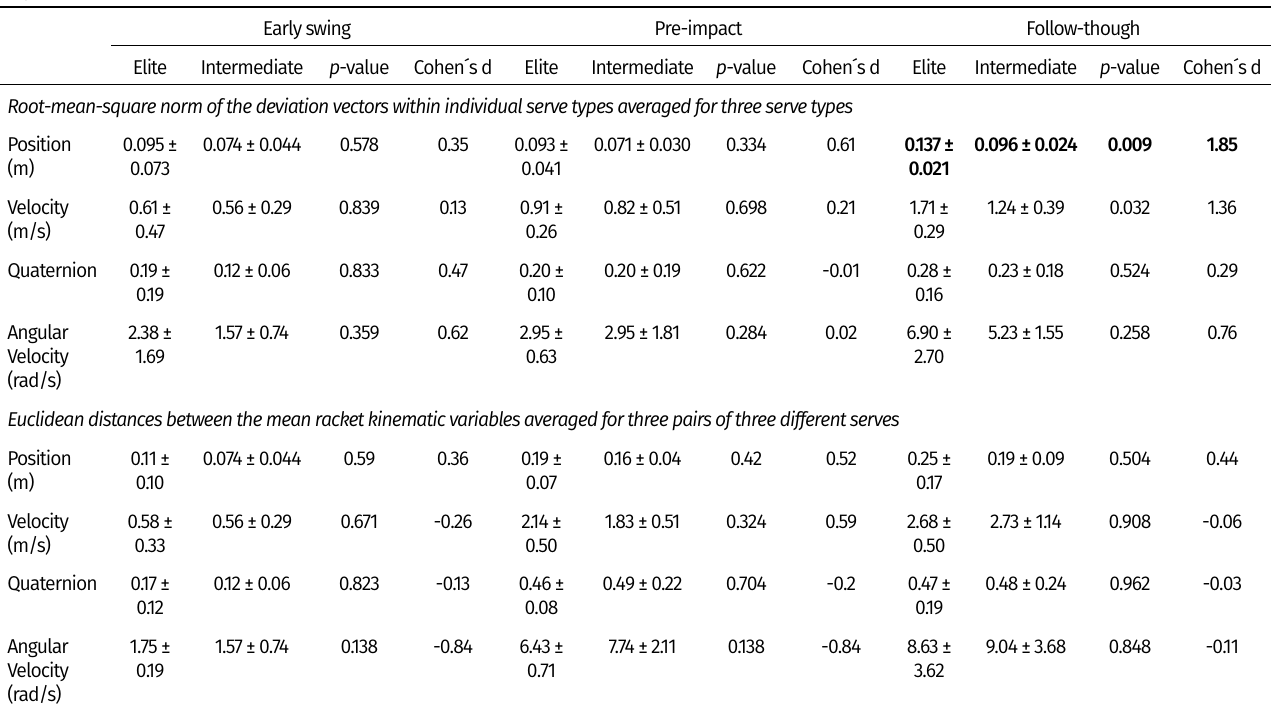
Table 2. Root-mean-square norm of the deviation vectors of four racket variables within individual serve types averaged for three serve types and euclidean distance between the mean racket kinematic variables averaged for three pairs of three different serves in elite and intermediate